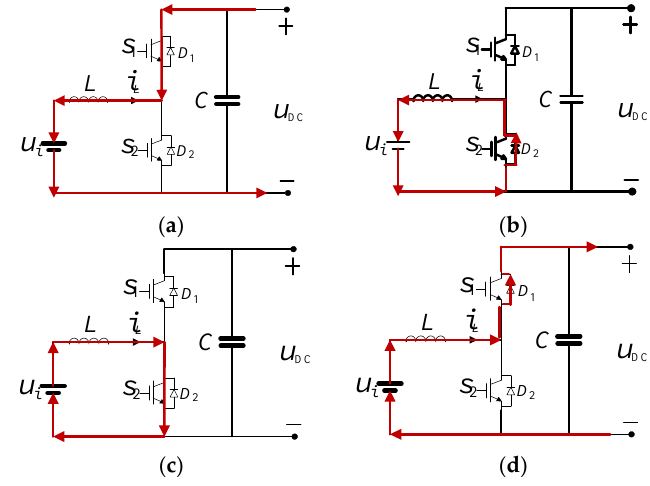
Figure 7. Current paths of the interface circuit of super capacitors and batteries. ( a ) Buck mode, S 1 is on; ( b ) Buck mode, D 2 is on; ( c ) Boost mode, S 2 is on; and ( d ) Boost mode, D 1 is on.